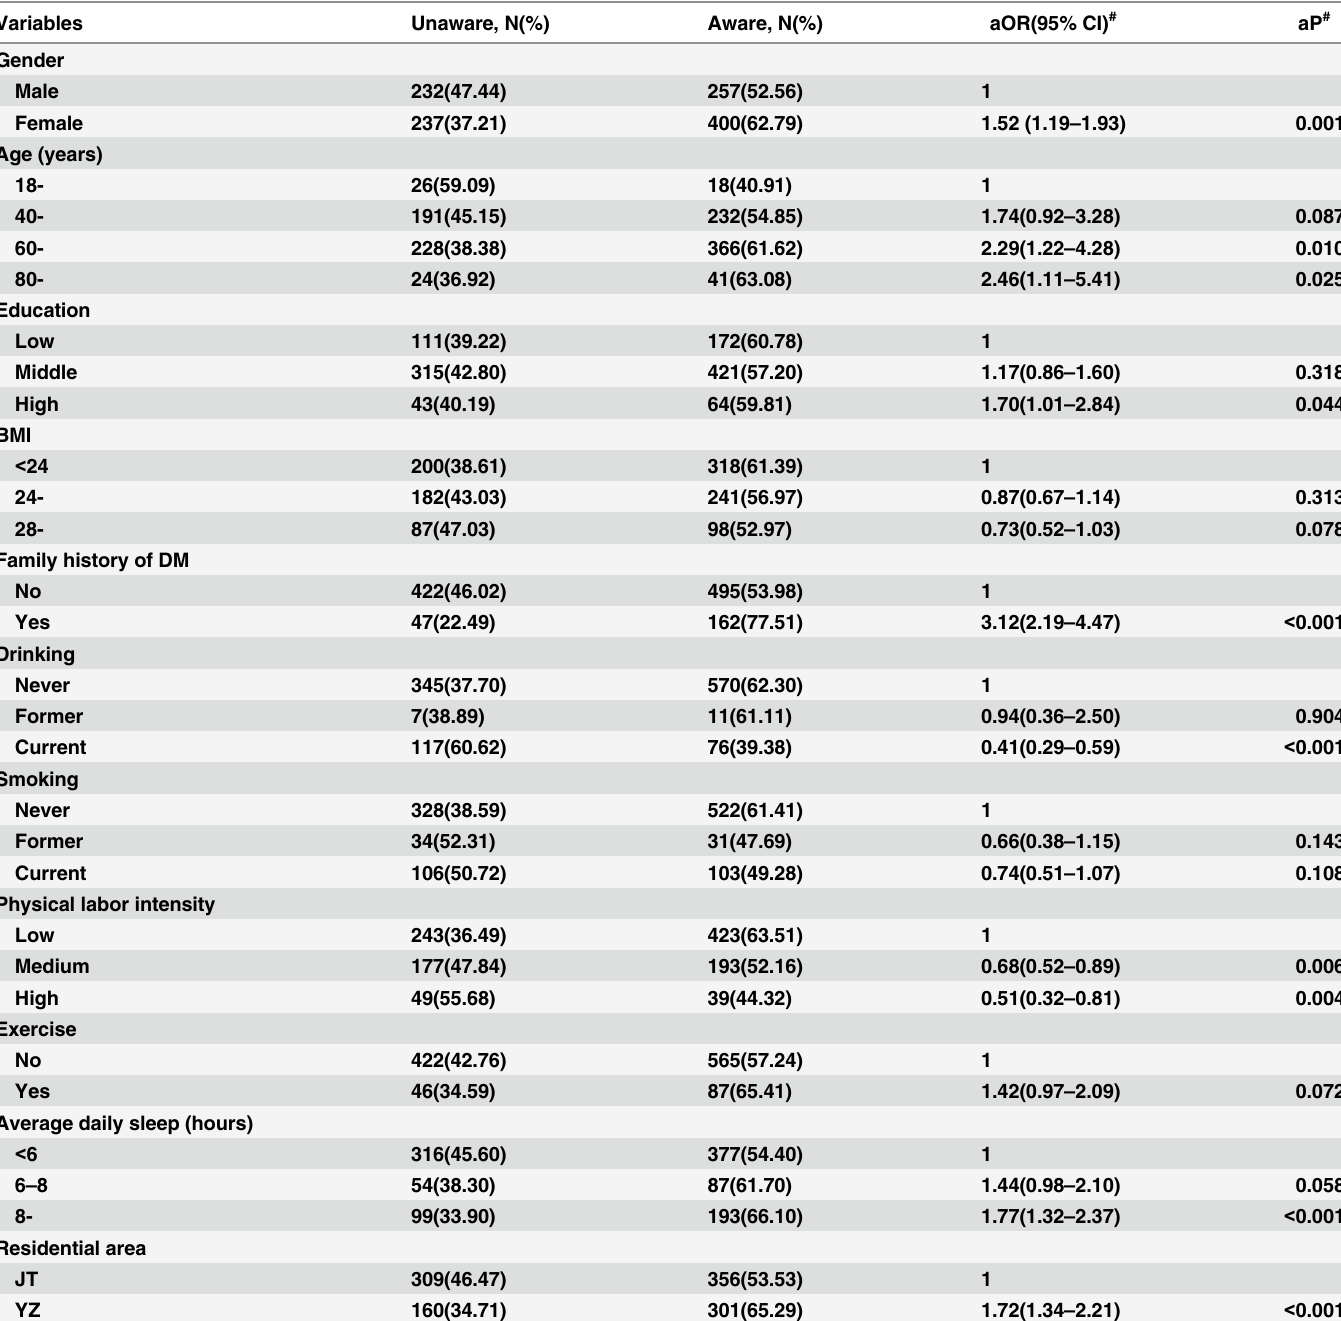
Table 4. Factors associated with diabetes mellitus